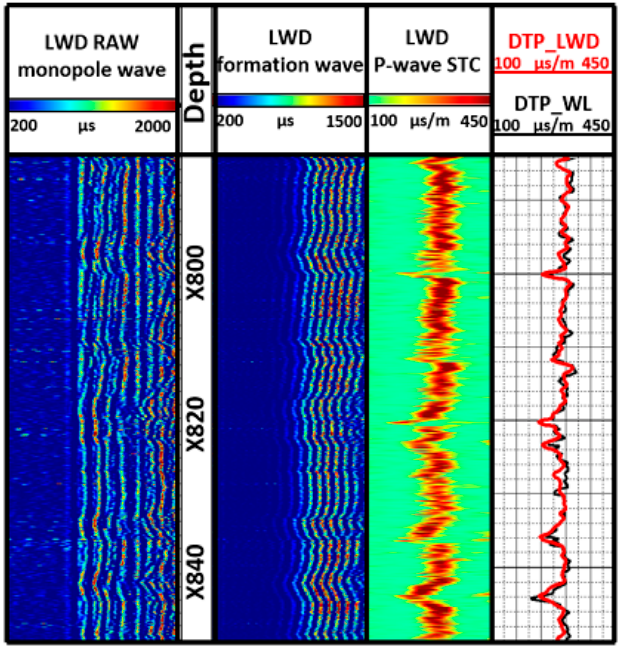
Figure 19. Comparison of LWD and wireline logging results in X ‐ 3 well.